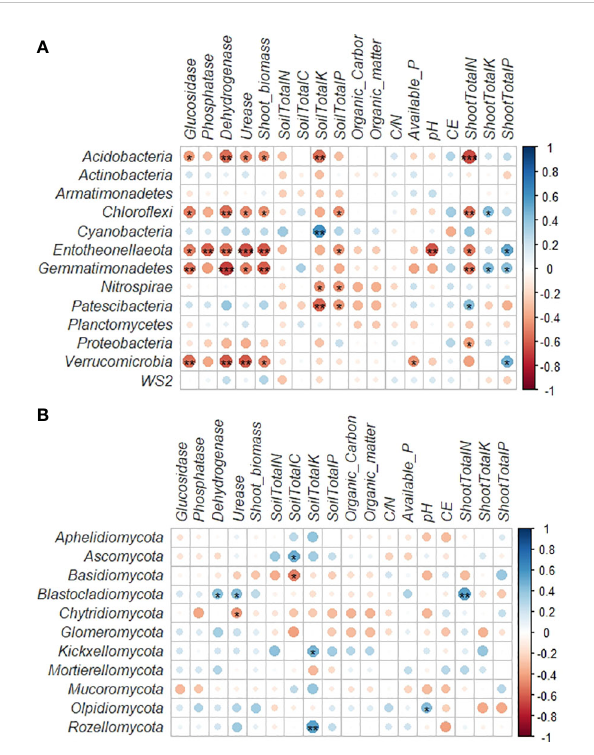
FIGURE 4 (A) Correlations between the dominant bacterial phyla and soil properties and plant parameters. The R value is shown in different colours in the fi gure. If the P -value is < 0.05, it is marked with an asterisk. *0.01 < P ≤ 0.05; **0.001 < P ≤ 0.01; ***P ≤ 0.001. (B) Correlations between the dominant fungal phyla and soil properties and plant parameters. The R value is shown in different colours in the fi gure. If the P -value is < 0.05, it is marked with an asterisk. *0.01 < P ≤ 0.05; **0.001 < P ≤ 0.01; ***P ≤